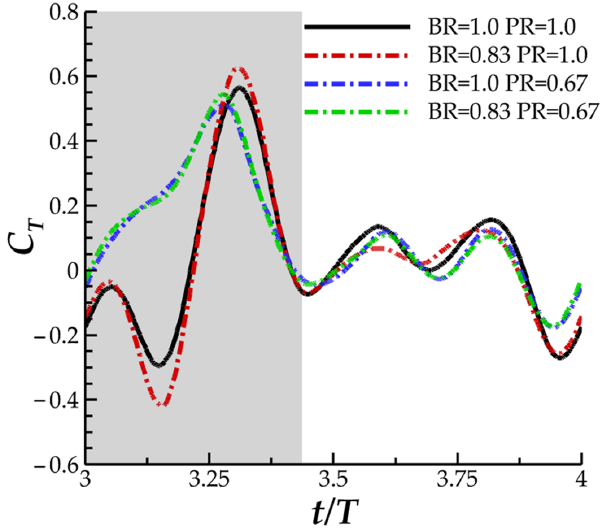
Figure 12. Instantaneous thrust performance comparison for newly added case 7 with BR = 0.83 PR = 0.67.